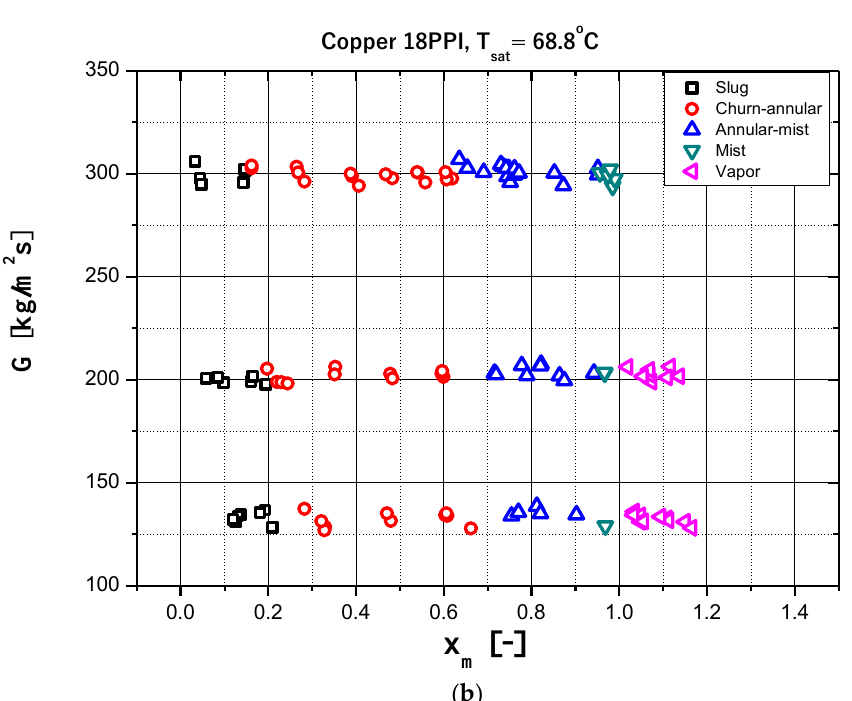
Figure 8. Flow pattern maps based on the vapor quality and mass flux ( a ) in a plain channel and ( b ) in 18-PI copper porous media filled channel at T sat = 68.8 °C.